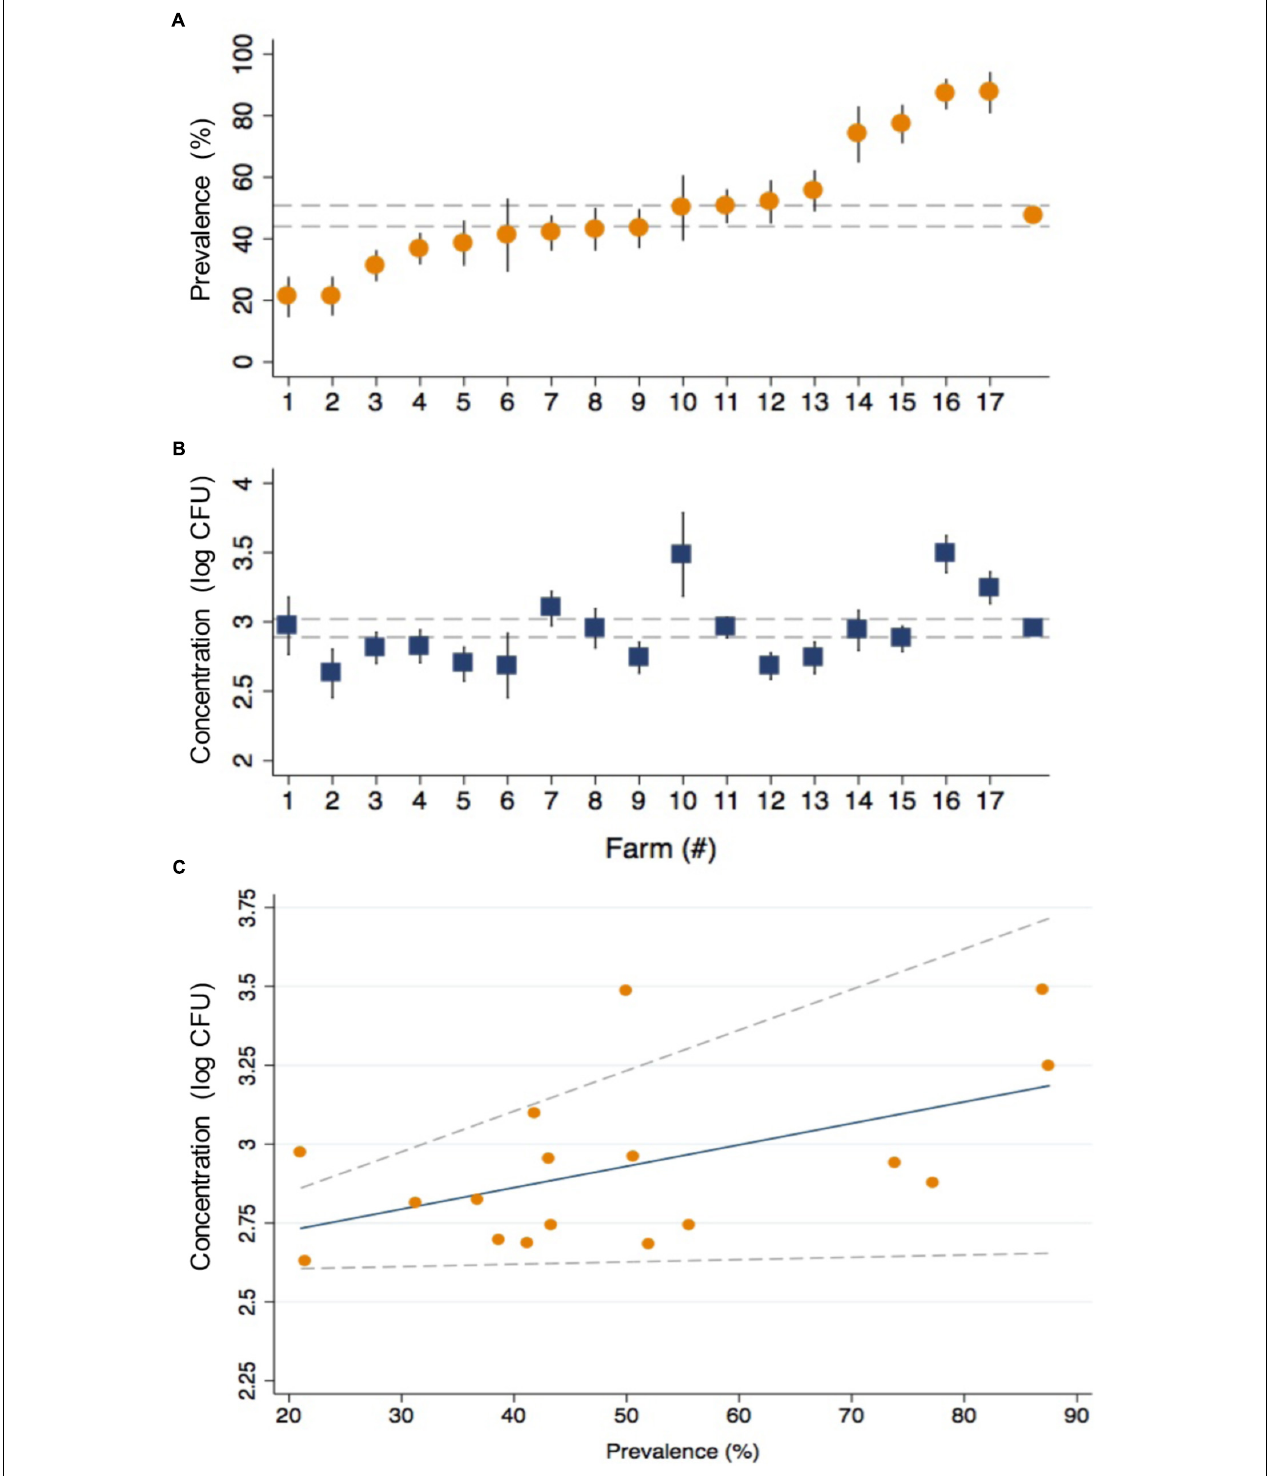
FIGURE 2 | The prevalence and concentration of CRB in beef cattle from 17 cow/calf operations in North and Central Florida. The prevalence (A) and concentration (log 10 CFU) (B) of CRB detected in the fecal samples collected from calves and cows are presented with the corresponding standard error (black spike) for the 17 sample collection sites along with the average values from all farms (gray dashed lines). The relationship (C) between the concentration (log 10 CFU) and prevalence of CRB is presented as a scatter plot for the values obtained by farm (orange circles), with the predicted values from a linear regression model (blue line) and 95% confidence intervals (gray dotted lines).